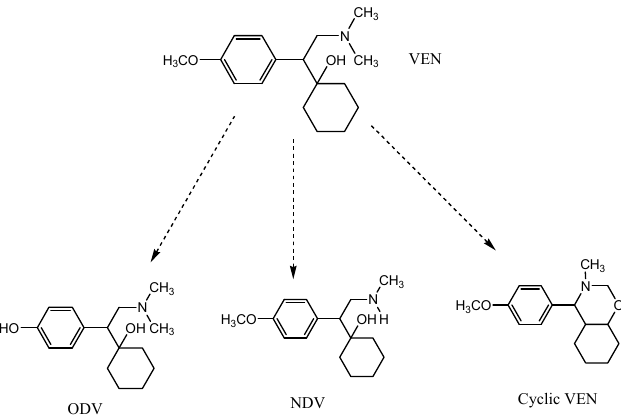
Figure 1. Metabolic reactions of venlafaxine (VEN) to produce O-Desmethylvenlafaxine (ODV), N-Desmethylvenlafaxine (NDN) and Cyclic VEN.